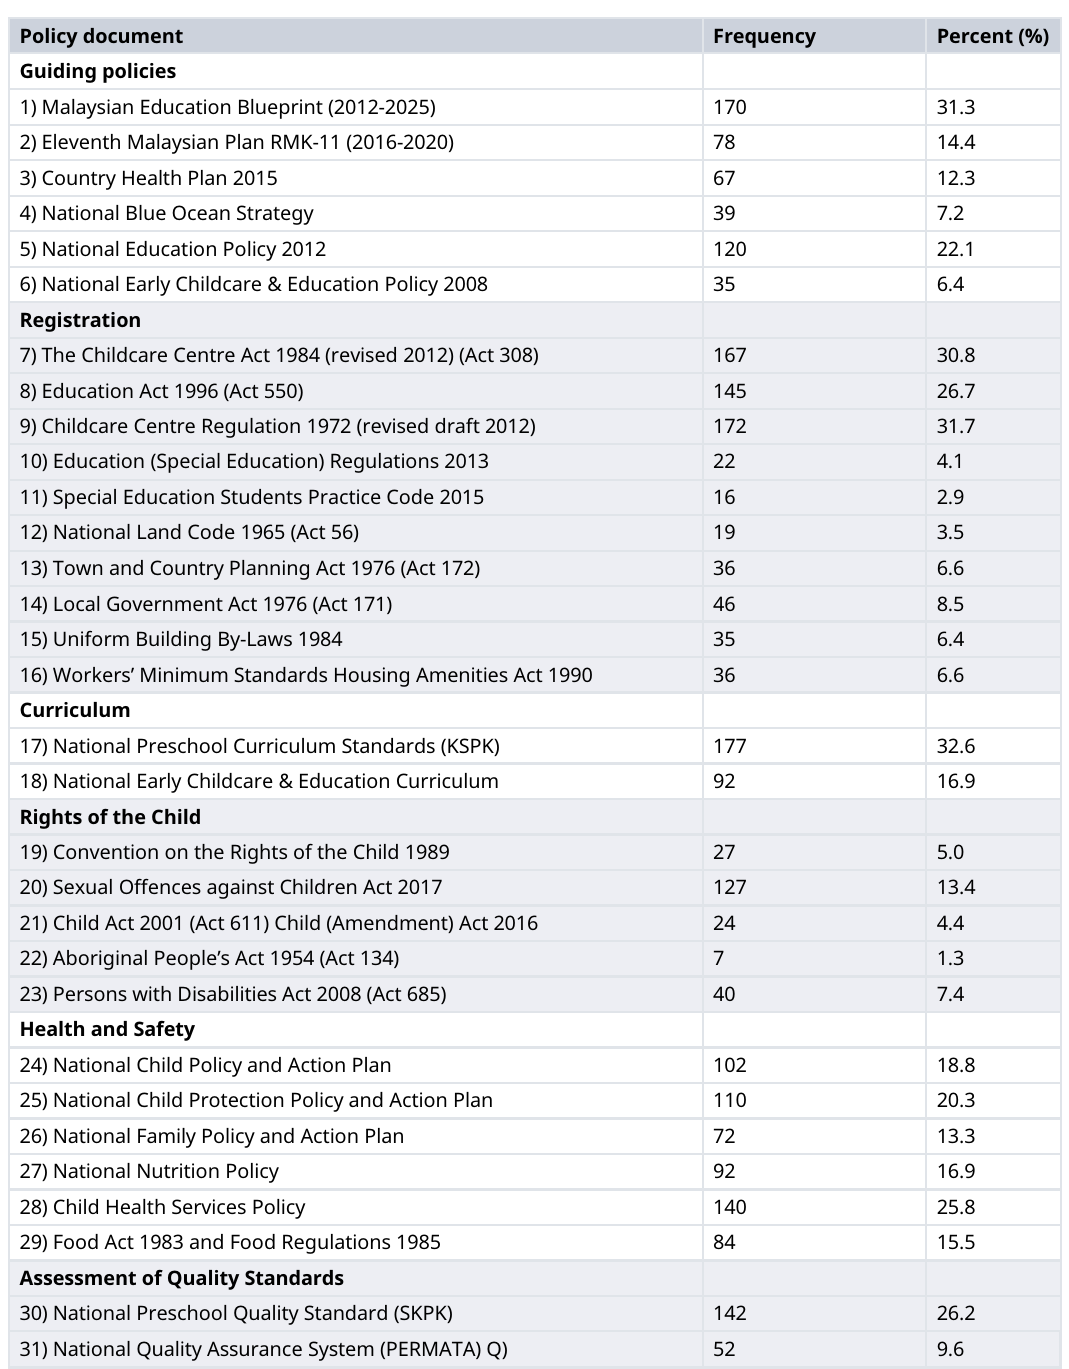
Themesare policyawareness, policyimplementation, andchallenges ofpolicyimplementation. Twocategoriesare under the theme of policy awareness: lack ECCE policy awareness and knowing little ECCE policy. During the focus group